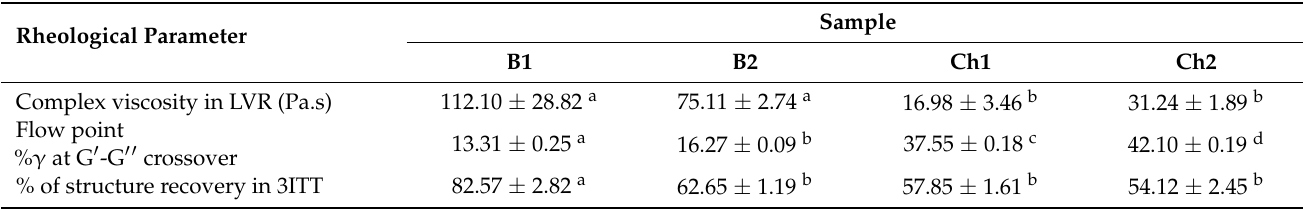
Table 6. Rheological parameters registered during low-amplitude oscillatory strain sweep and 3-interval thixotropy tests for broad bean and chickpea fermented products.